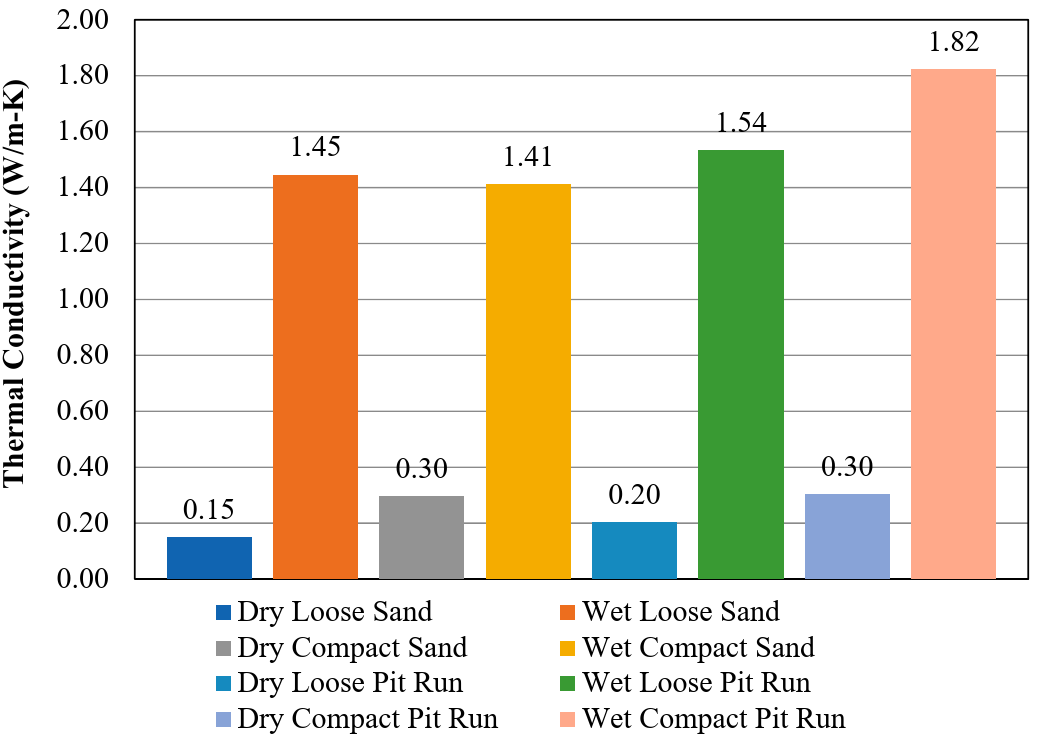
Figure 8. Thermal conductivity of soil samples.